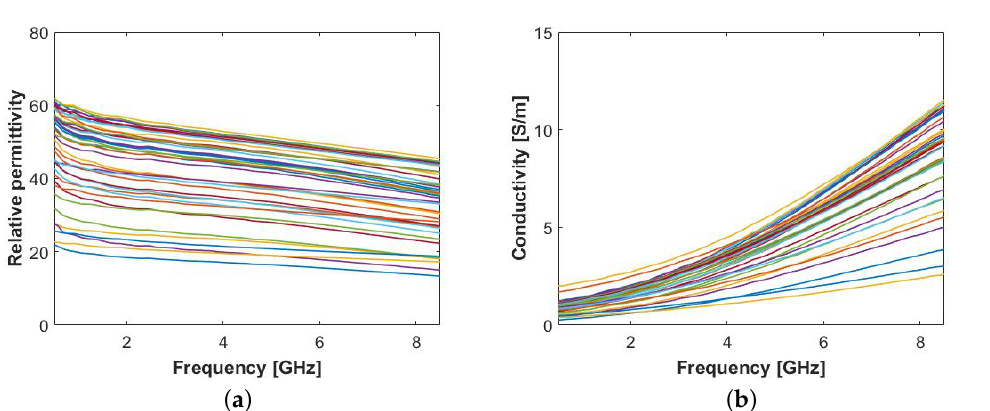
Figure 3. Permittivity results obtained from animal lymph node surface layer: ( a ) Relative permittivity, (cid:101) (cid:48) , and ( b ) conductivity, σ .